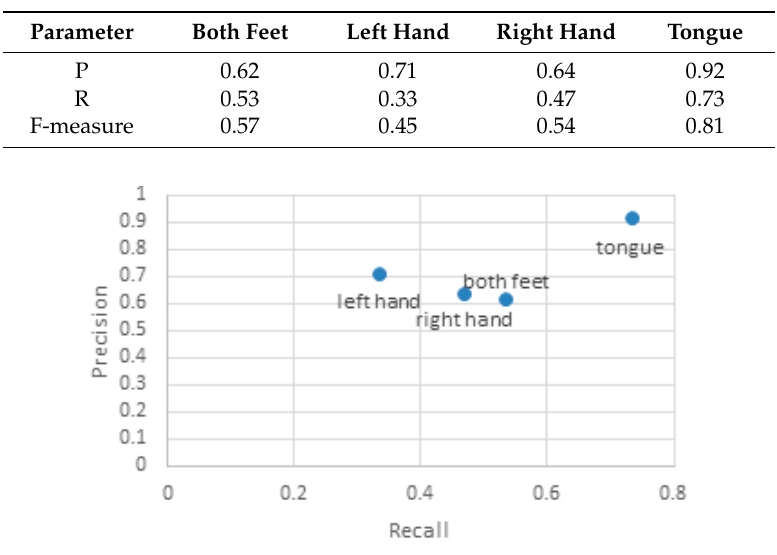
Table 7. Comparison of classification accuracy (CA, %) and the number of features selected (FS) between the three algorithms: GA, APSO, and FA-LA, for real-time MI EEG signals.